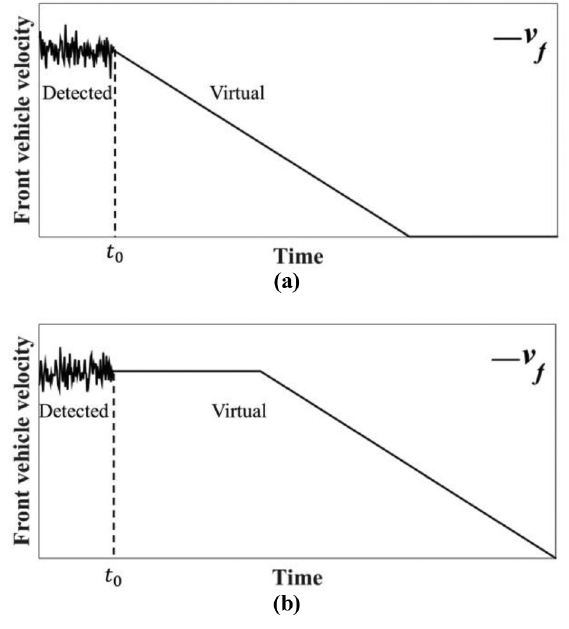
Figure 4 Velocity prediction of the virtual